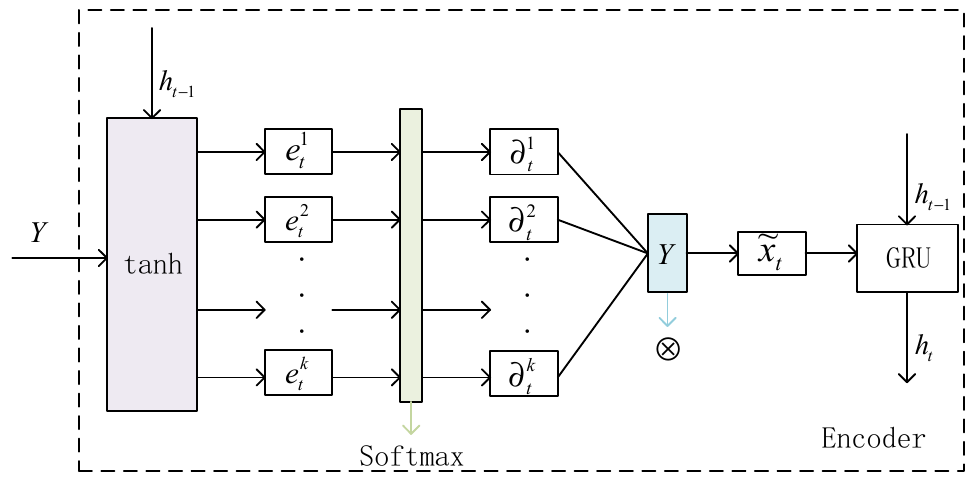
Figure 3. Coding stage.